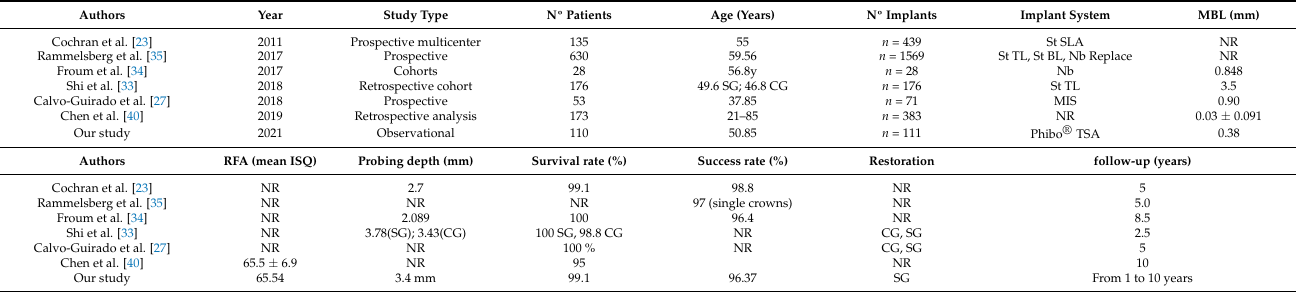
Table 2. Results of this study in comparation with other similar studies of the